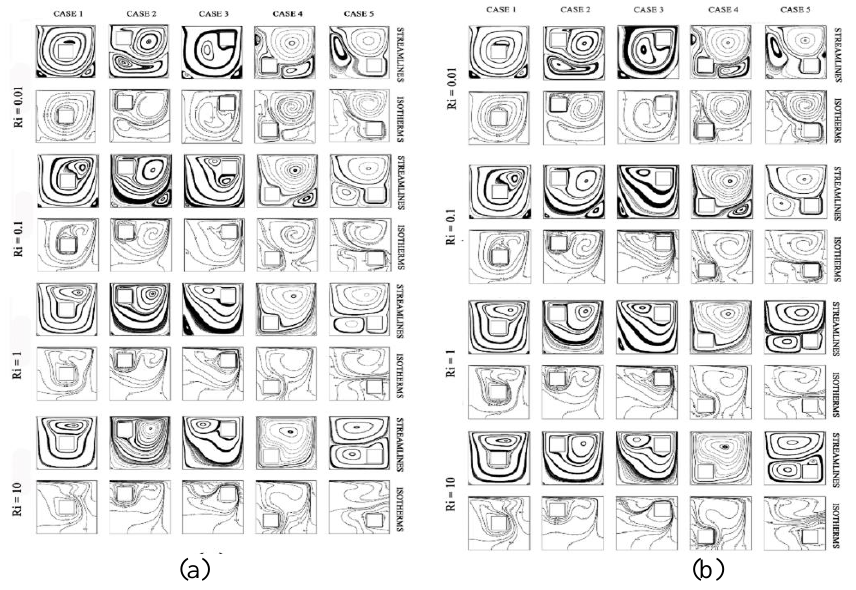
Figure 6. Streamlines and isotherms for various geometrical cases (a) Ø = 1 % and (b)